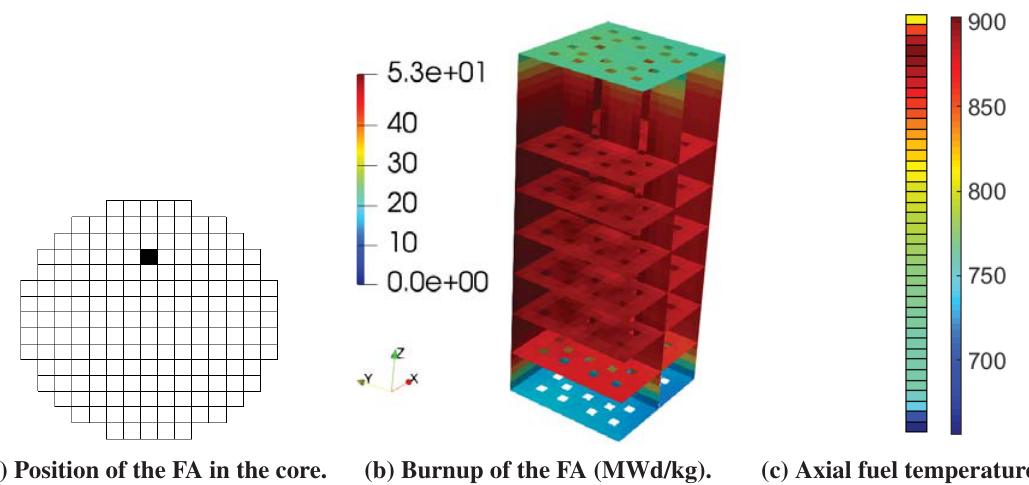
Figure 1: Description of the application